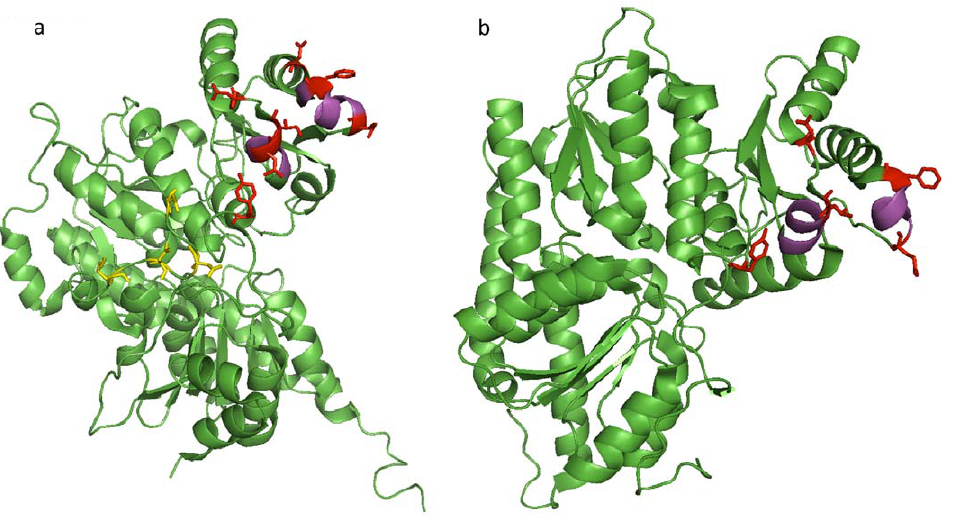
Figure 4. Binding sites between Fe-protein and MoFe-protein. Binding sites inferred on a (a) and b (b) subunits of MoFe protein, PDB chain 1MIO_A and 1MIO_B respectively. Two helical regions assumed to be critical for interaction are shown in magenta. Binding site residues are shown by side chains (in red color) and match with residues predicted by Kim at al. Binding site residues shown in yellow on a subunit (1MIO_A) are part of inserted 50 residues sequence and are not predicted by IBIS. doi:10.1371/journal.pone.0028896.g004 PLoS ONE |